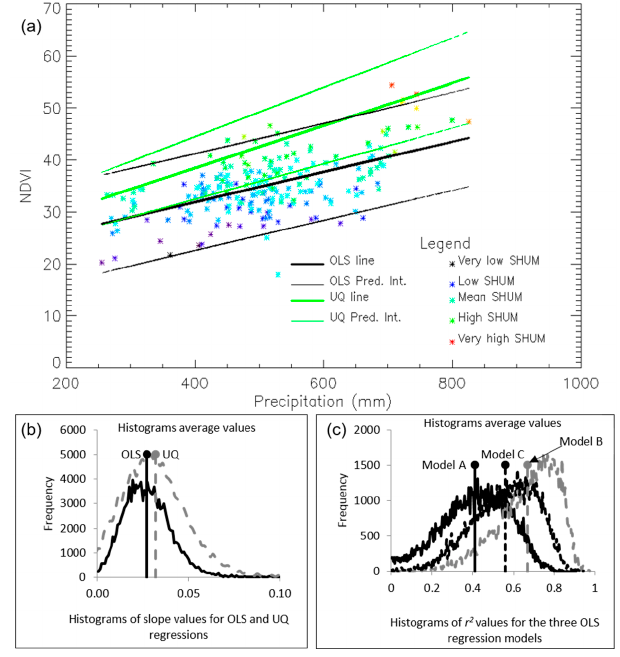
Figure 1. Properties of the models used to estimate potential Σ NDVI gs from the relationship between observed Σ NDVI gs and climate variables. ( a ) The OLS and UQ regression lines of Σ NDVI gs on precipitation and their prediction intervals (Pred. Int) at the 95% confidence level for a cropland site (3.725°W, 11.525°N); ( b ) The difference between the OLS and UQ precipitation coefficient values for all sites throughout the Sahel study region; ( c ) The ability of precipitation (model A), precipitation and its intra-seasonal distribution (model B) and precipitation, specific humidity and temperature (model C) to account for the variations in Σ NDVI gs . SHUM—specific humidity.